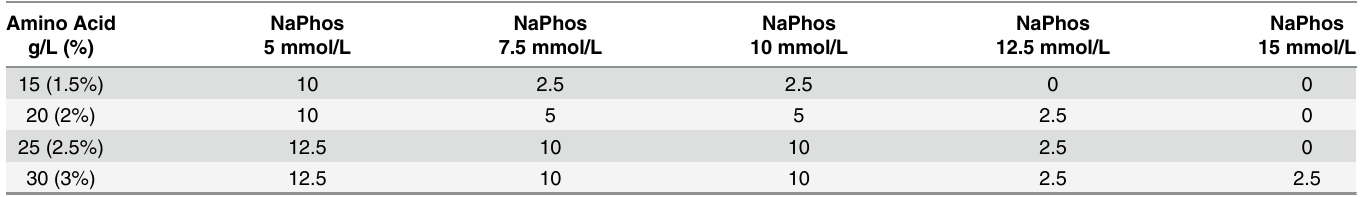
CaCl 2 , calcium chloride; NaPhos, sodium phosphate.